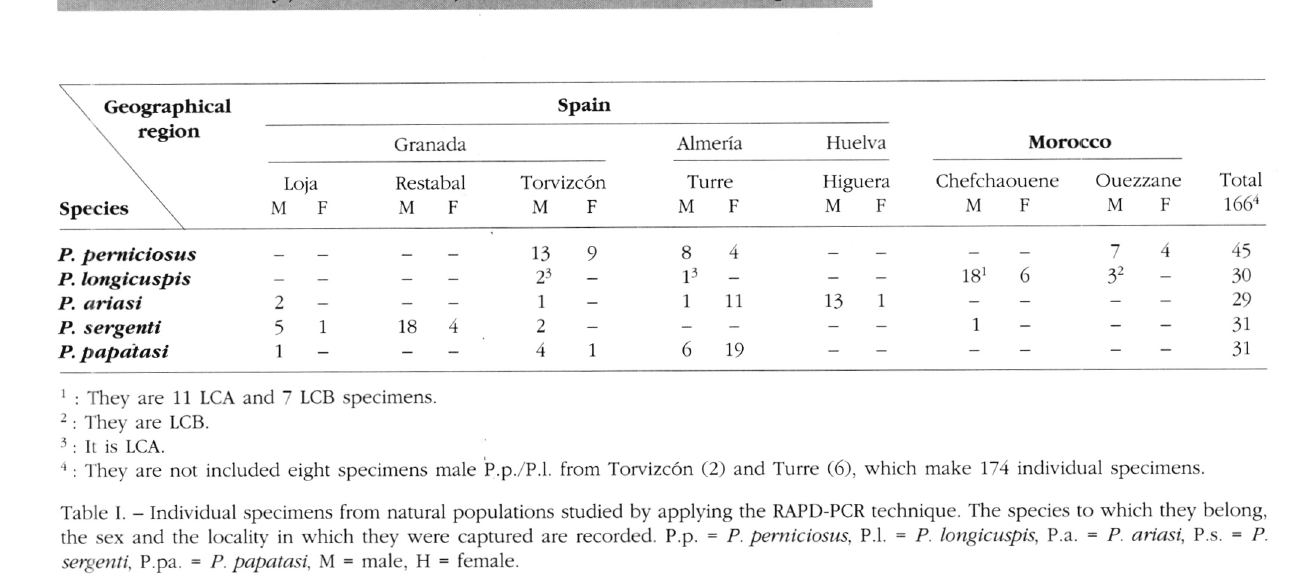
Table I. - Individual specimens from natural populations studied by applying the RAPD-PCR technique. The species to which they belong, the sex and the locality in which they were captured are recorded. P.p. = P. perniciosus, P.l. = P. longicuspis, P.a. = P. ariasi, P.s. = P. sergenti , P.pa. = P. papatasi, M = male, H =